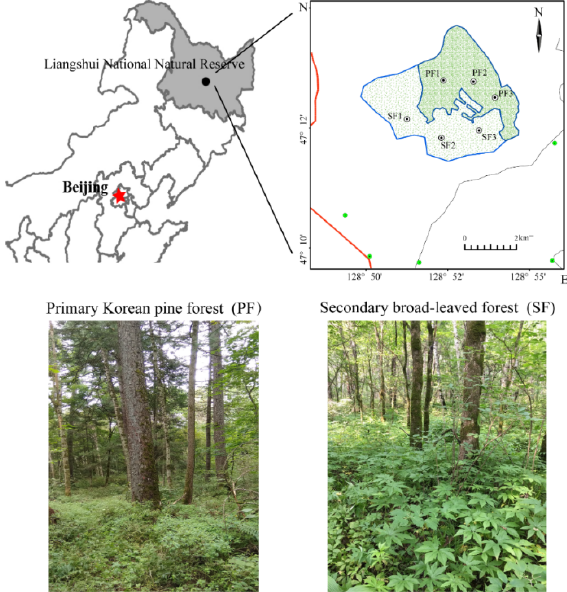
Figure 1. Distribution of the two sample sites. PF: Primary Korean pine forests, SF: Secondary broad ‐ leaved forests.